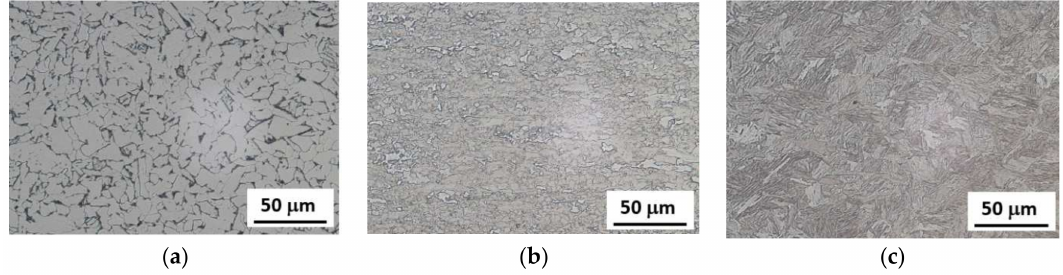
Figure 1. Microstructural images of investigated steels. ( a ) S235, ( b ) MC700, ( c )